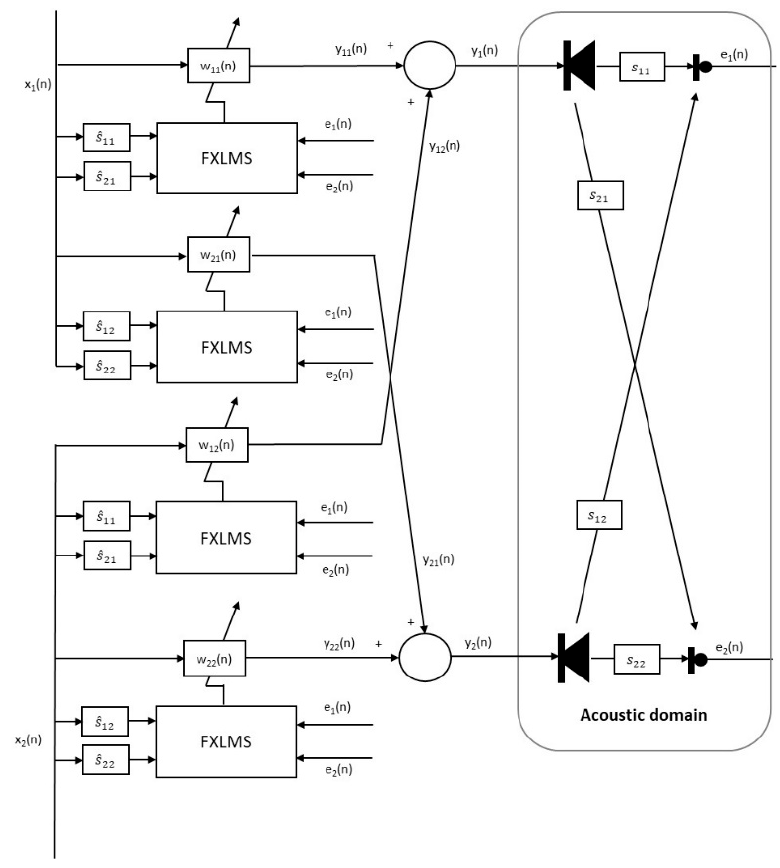
Figure 3. The block diagram of the 2 × 2 × 2 FxLMS algorithm for active noise cancellation of the